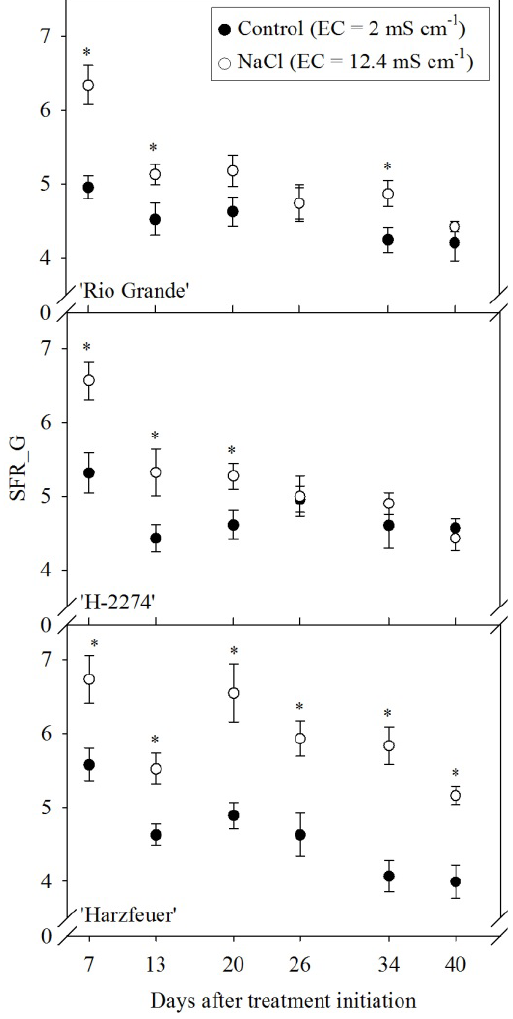
Figure 5. The ratio of far-red fluorescence to red fluorescence after green light (SFR_G). Readings were taken on tomato leaves from “Rio Grande”, “H-2274” and “Harzfeuer”. Values represent the mean ± SE ( n = 10). * Significant differences ( p ≤ 0.05) between control and NaCl treatment for each genotype and measuring day, assessed by t